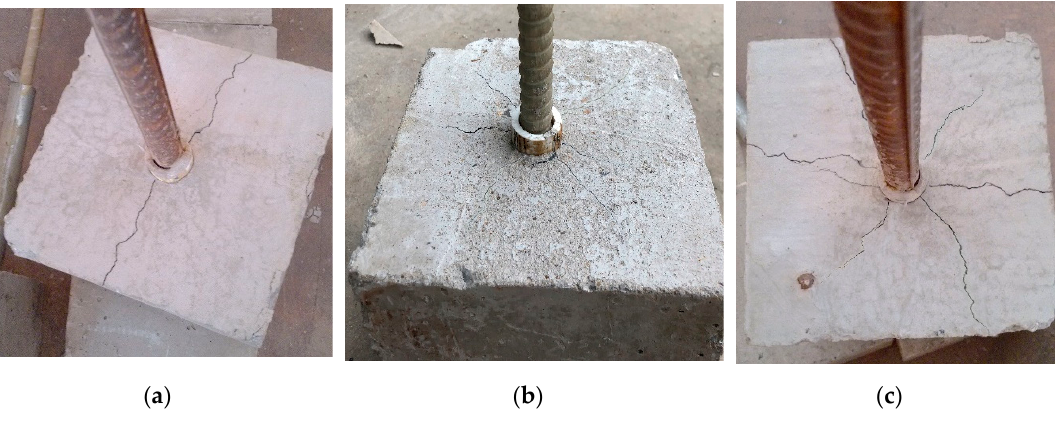
Figure 12. Typical cracking behavior of specimens ( a ) R4-C1-20-N-1, ( b ) R3-C1-20-Y-2, and ( c ) R4-C1-20-Y-2.